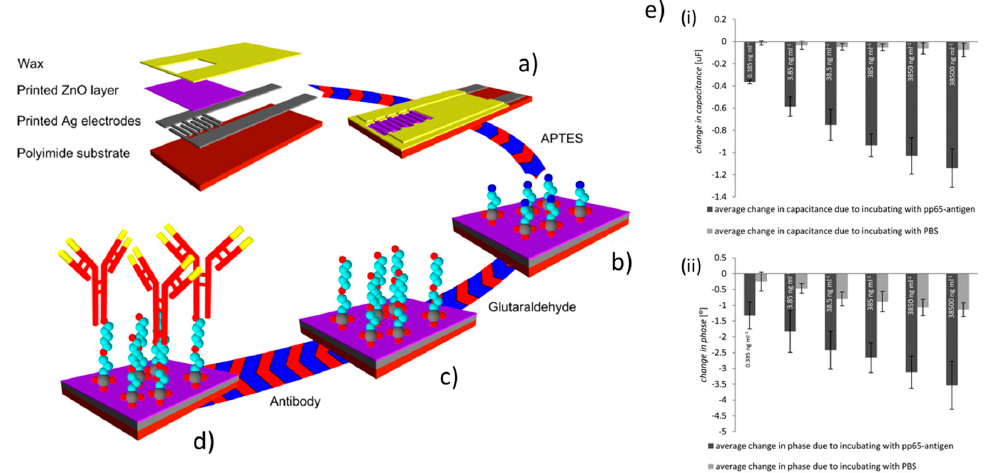
Figure 11. Applications in EIS sensors. Schematic illustration of the printed biosensor (a) and its fabrication, and of the functionalization steps (b) covalent linkage of (APTES) to ZnO, (c) modification of APTES layer with glutaraldehyde, (d) antibodies linkage via aldehyde groups of glutaraldehyde. (e) Biosensor pp65-antigen sensing recorded in presence/absences of pp65-antigen in phosphate-buffered saline (PBS) at 50 mHz (i) change in capacitance and (ii) change in phase. Reprinted with permission from Reference [105]; Copyright 2016 American Chemical Society.